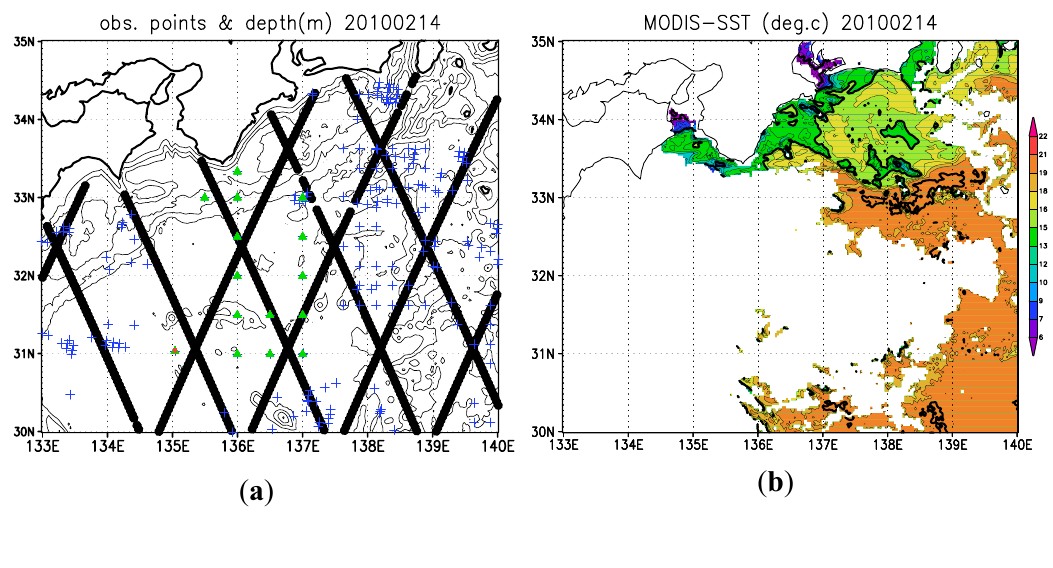
Figure 1. ( Left ): Positions of the observation data without Moderate Resolution Imaging Spectroradiometer (MODIS-SST). Thick lines: sea surface height anomaly, crosses: satellite sea surface temperature, triangles: in situ temperature, squares: in situ salinity. Contours denote iso-depth lines: 10, 20, 30, 40, 50, 100, 200, 500, 1,000, 2000, 3000, 4,000, and 5,000 m. ( Right ): Snapshots of MODIS-SST gridded on the model grid for visualization. Note that the assimilated data with approximately 1 km resolution themselves are not gridded on the model grid of 1/36 (cid:68) resolution. Interval of thin (thick) contours is 1 °C (5 °C). ( a , b ): 14 February 2010. ( c , d ): 20 February 2010. ( e , f ): 26 February 2010. The abbreviations in ( f ) represents locations: KC (Kii Channel) and II (Izu